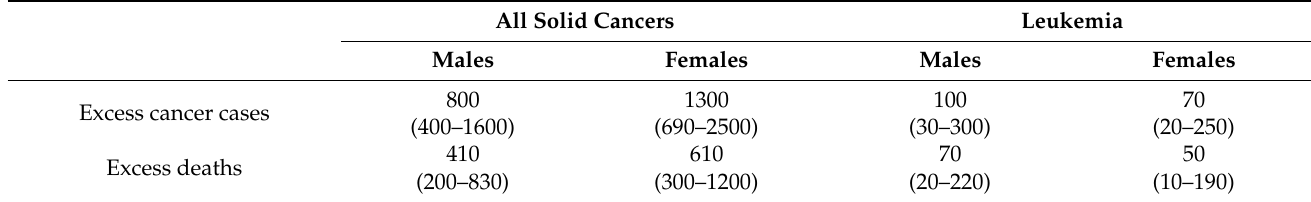
Table 3. The BEIR VII preferred estimates of the lifetime attributable risk of cancer incidence and mortality from exposure to 100 mSv per 100,000 persons (95% subjective confidence